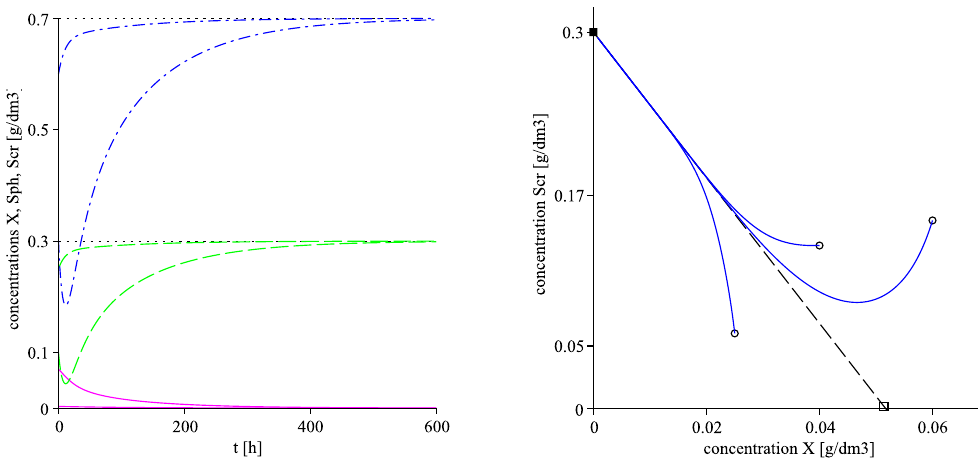
Figure 6. D = 0.095. ( Left ): time evolution of solutions X (solid line), S ph (dash-dot line) and S cr (dash line); the horizontal dot lines pass through the corresponding components of the equilibrium point E 0 . ( Right ): projections of the trajectories in the ( X , S cr ) -phase plane with three different initial points, denoted by circles. The corresponding equilibrium components of E 0 are marked by a solid box, of E 2 are denoted by a box. The dash line presents a projection of the invariant plane S cr + k cr X = S 0 cr